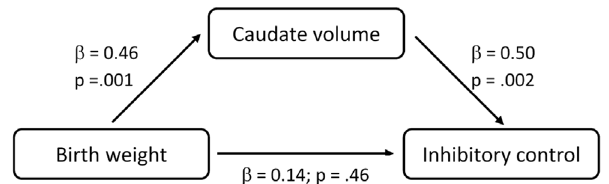
Figure 3. Mediation analysis for the effect of birth weight on inhibitory control via caudate volume. Model adjusted for sex and intracranial volume. Coefficients shown are standardized regression coefficients. The total indirect effect of birth weight on inhibitory control was statistically significant at p=.025. Omitting caudate volume from the analysis, birth weight was associated with inhibitory control, b =0.41, p=.043.